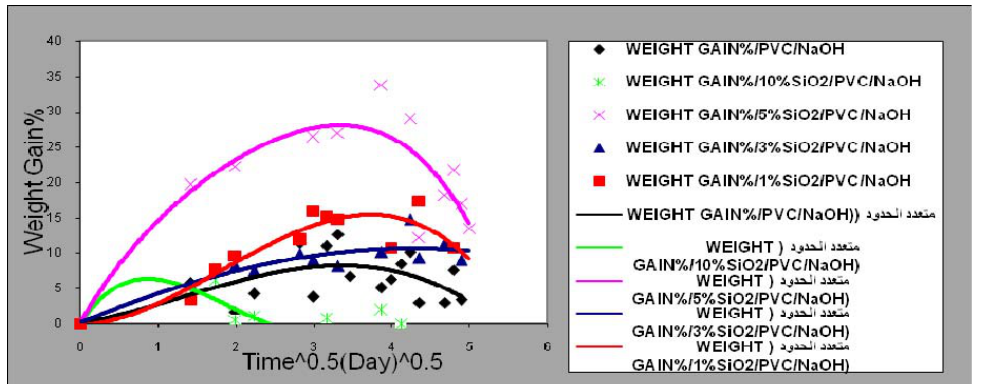
Fig.7: Weight gain (%) of PVC & SiO